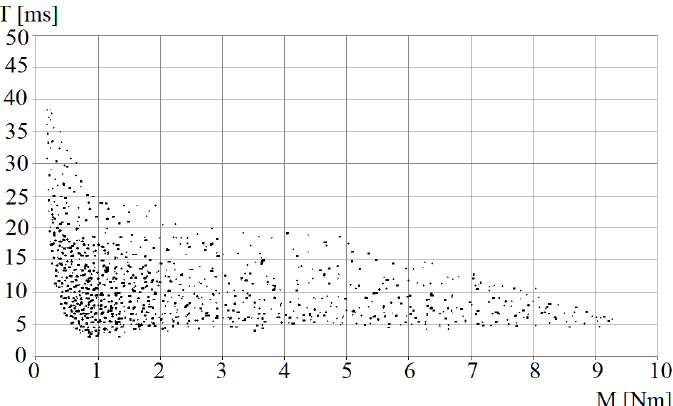
Figure 12. Dependence of the time T on the torque M.